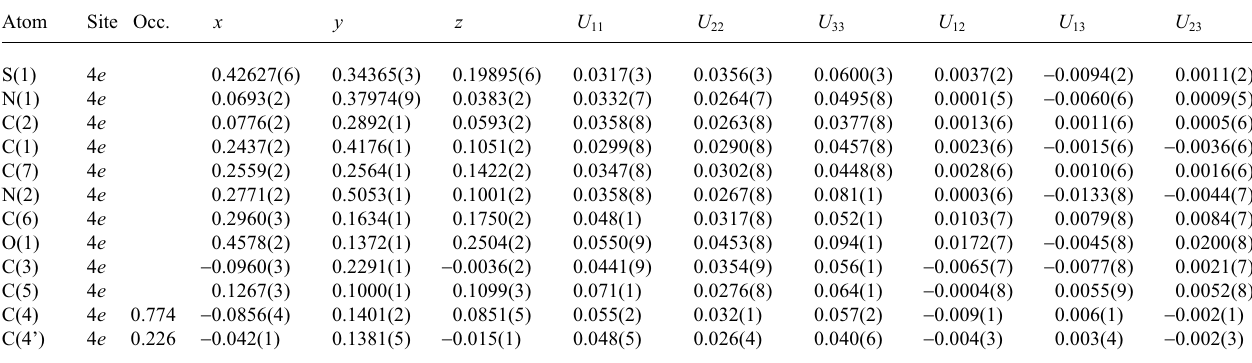
Table 3. Atomic coordinates and displacement parameters (in Å 2 ) . Site